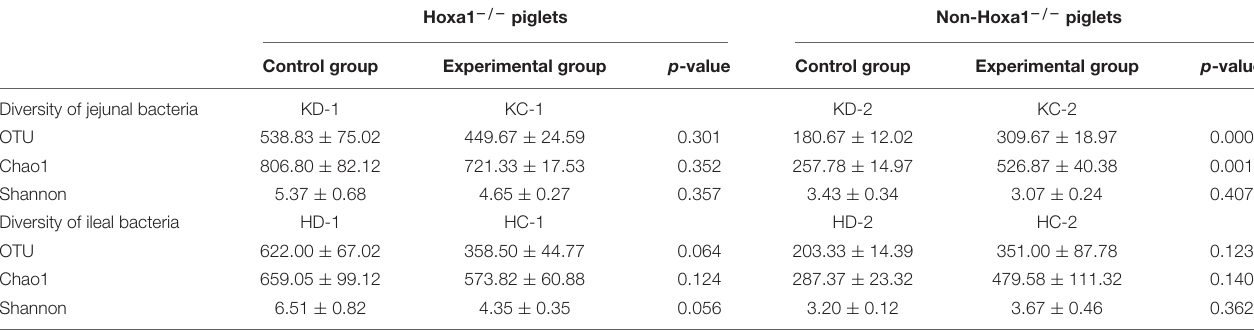
TABLE 2 | Diversity comparison of newly born piglets with the same genotype between the control group and the experimental